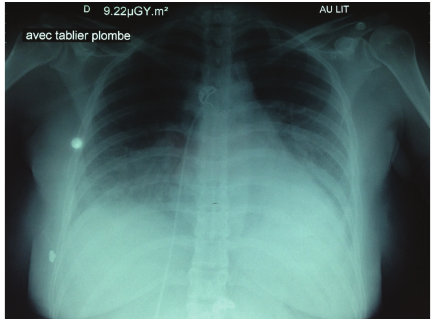
Figure 2: Chest X-ray face-on in prone position (Case